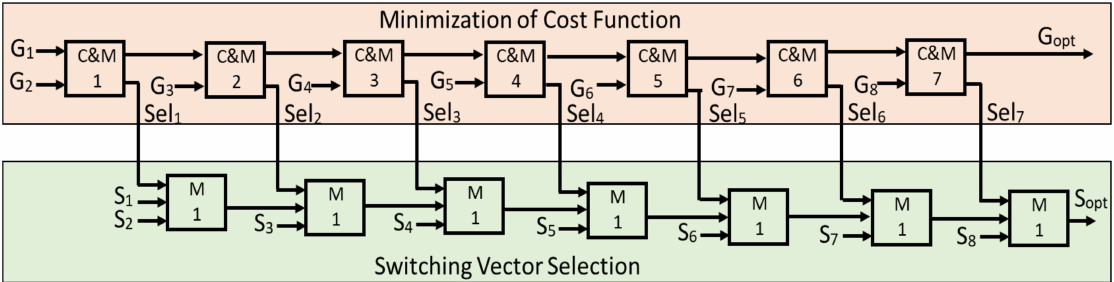
Figure 5. Cost function minimization and switching vector